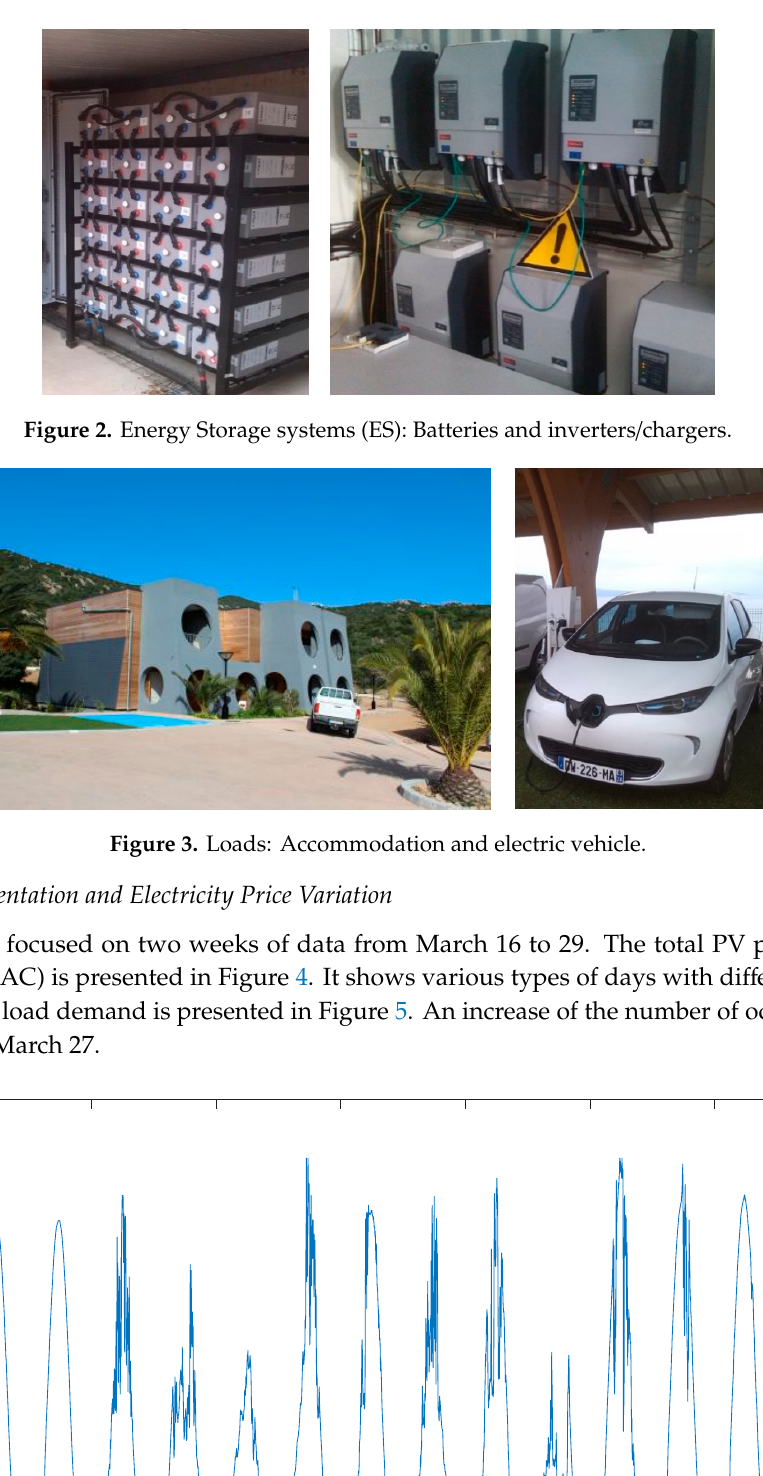
Figure 4. Total PV power from inverters.